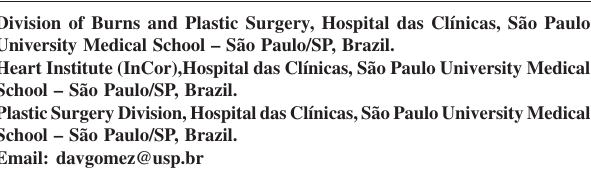
Figure 1 - Small iontophoresis